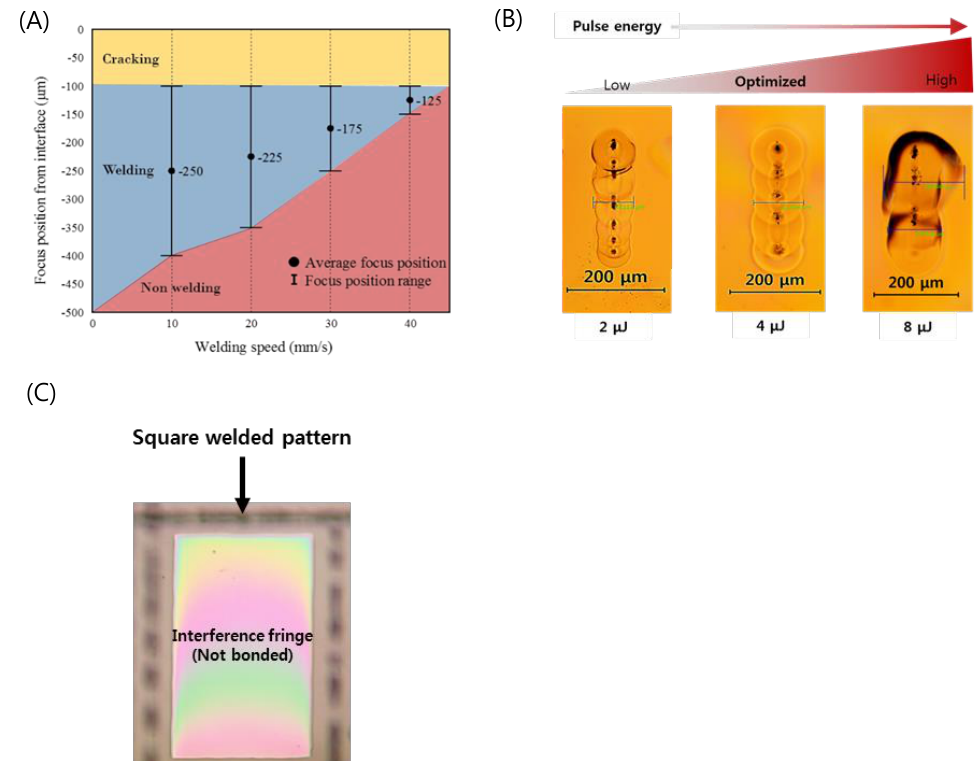
Figure 4. ( A ) Weldability map as functions of welding speed and focus position (E p = 4 μJ). ( B ) Optical images of welding seams with different laser pulse energies (Focal position from an interface: − 225 μm , Speed: 20 mm/s). ( C ) Selectively bonded square welded by optimized laser parameters (fringe-removed lines indicate successful bonding).